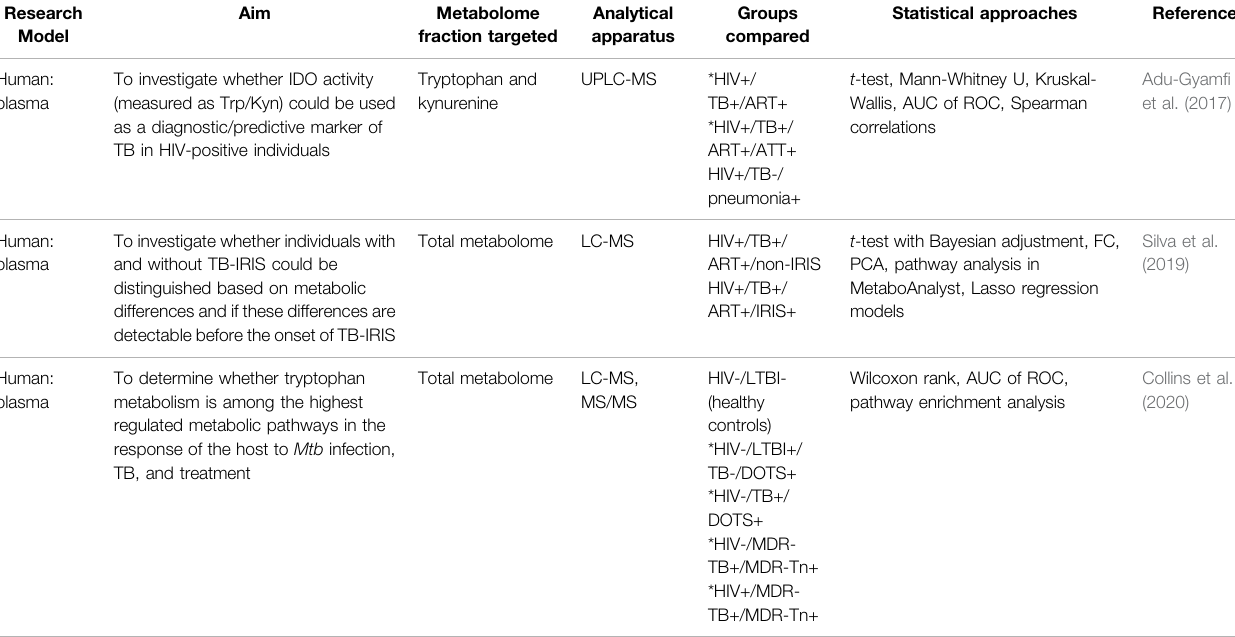
TABLE 1 | Metabolomics studies published to date investigating a speci fi c aspect of HIV/TB co-infection. Research